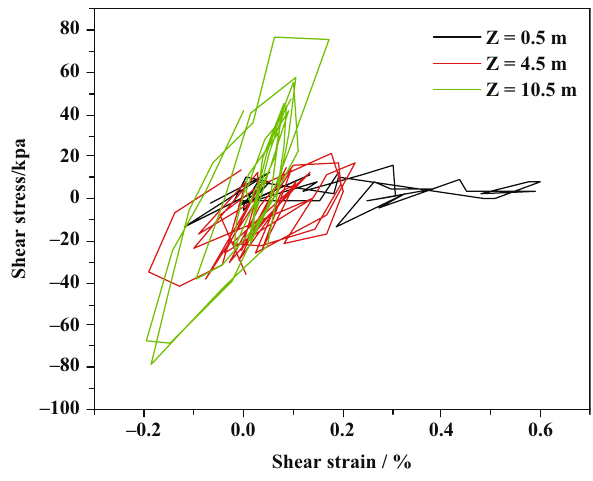
Figure 7: Dynamic response of soil mass at each depth at the top of the